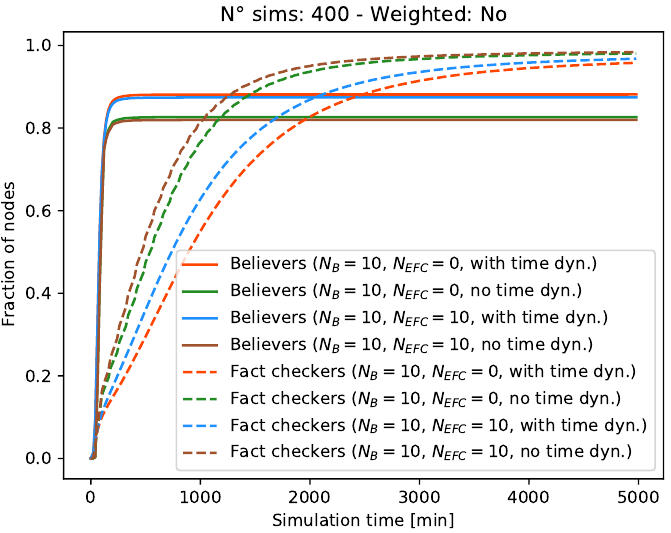
Figure 6. All-time maximum number of believers and fact-checkers over time with and without time